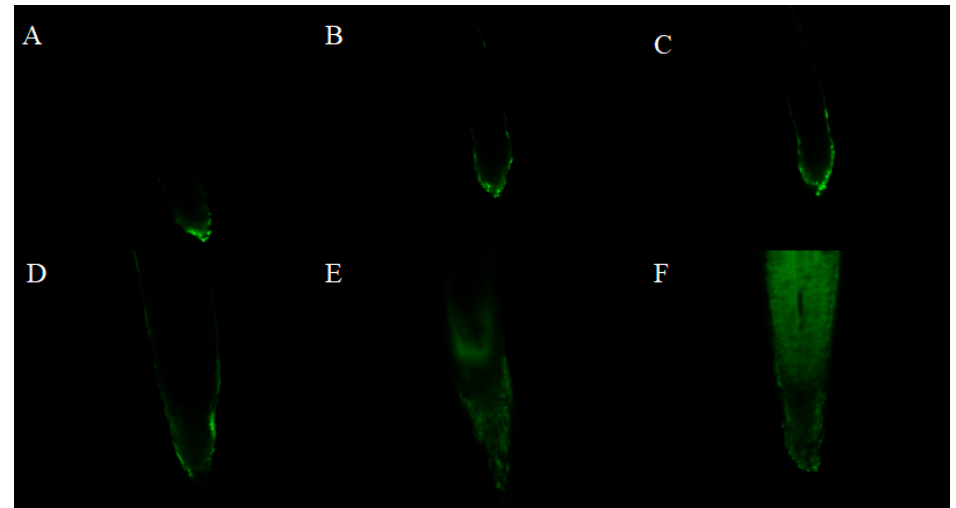
Figure 4. Representative pictures of ROS accumulation in lettuce radicle tips on treatment with different concentrations of isoliquiritigenin ( A : control, B : 0.2 mM, C : 0.4 mM, D : 0.6 mM, E : 0.8 mM, F : 1.0 mM).